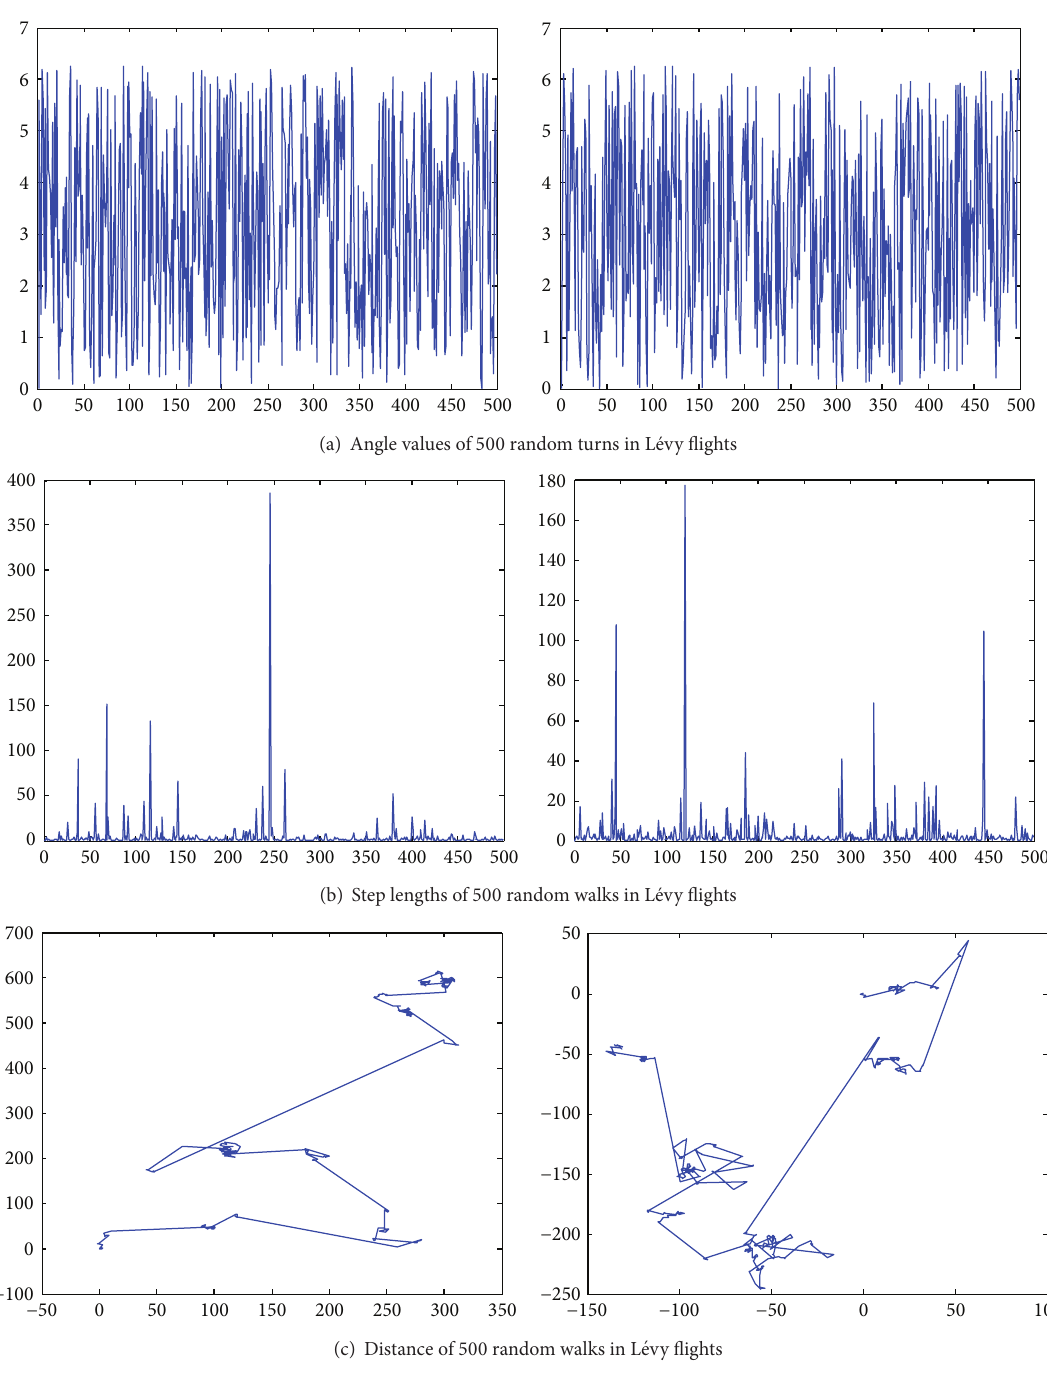
Figure 3: 2D L´evy flights in 500